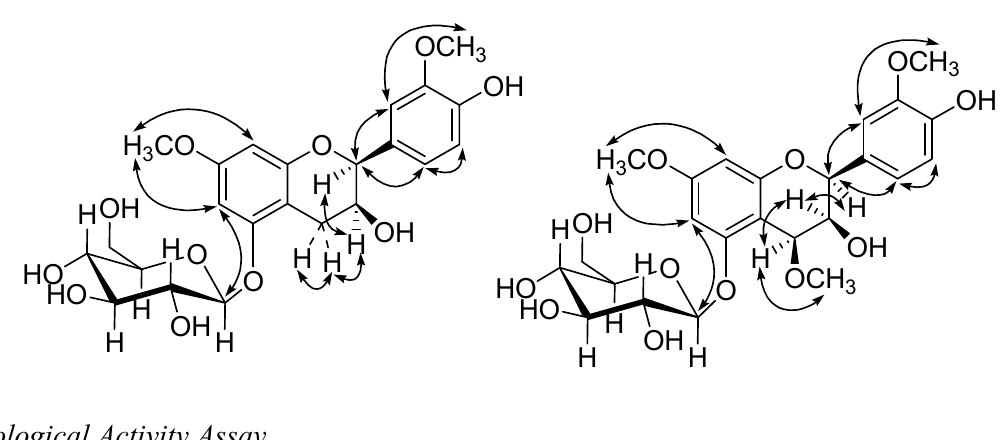
Figure 5. Key NOE correlations of 3 and 4